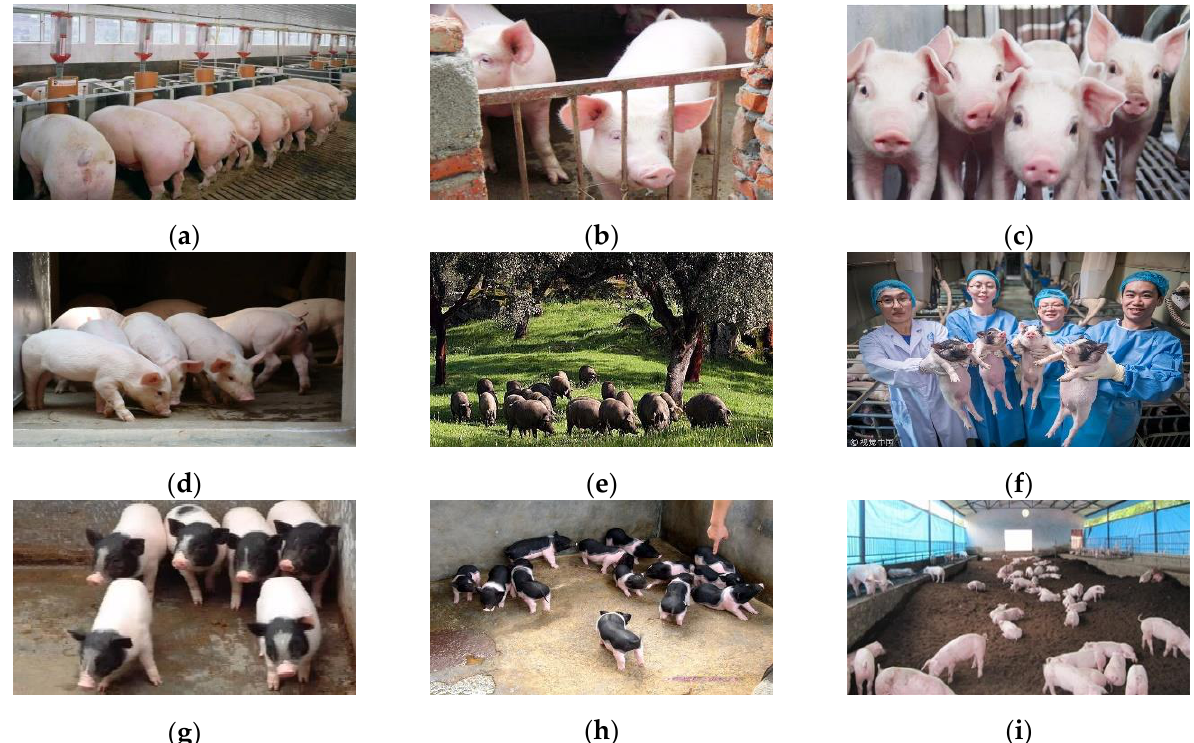
Figure 2. Pig images in different environments: ( a ) overlap of pigs; ( b ) object occlusion; ( c ) adhesion of pigs; ( d ) light; ( e ) nature; ( f ) other interfering factors; ( g ) lightweight herd (1 – 10 pigs); ( h ) middleweight herd (10 – 20 pigs); ( i ) heavyweight herd (over 20 pigs).